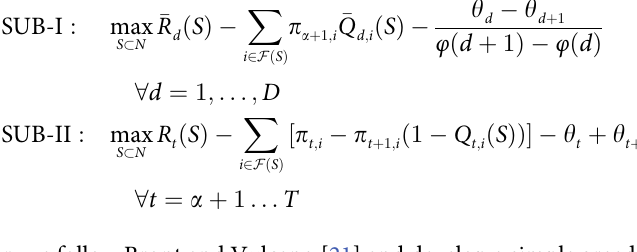
Algorithm 2 Simple Greedy Heuristic for